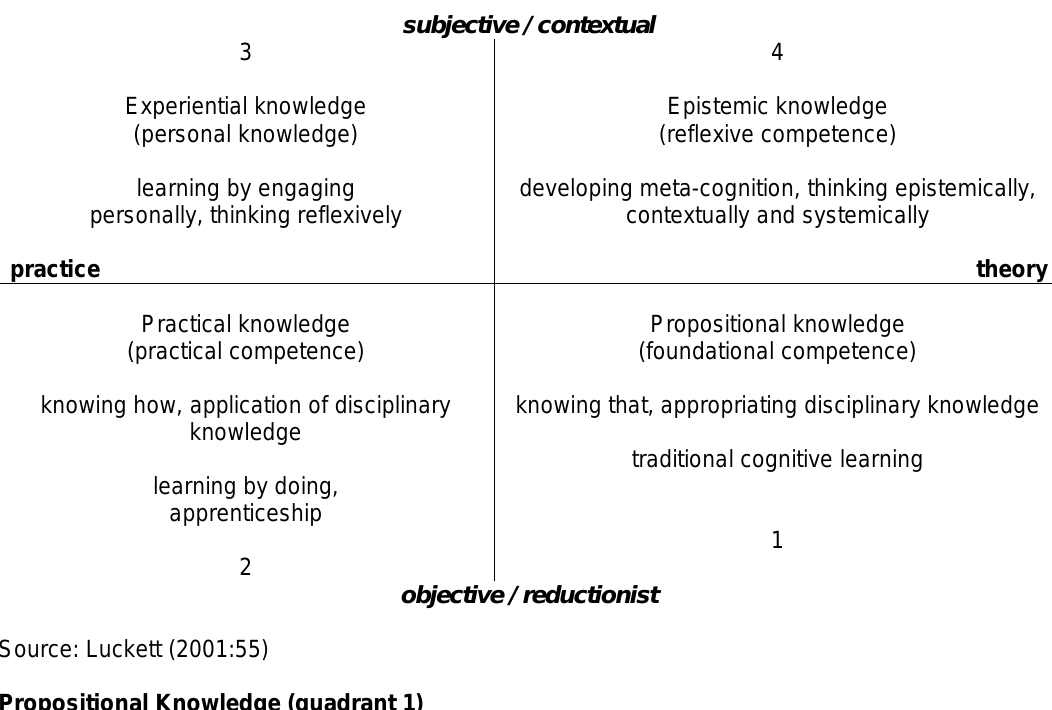
Figure 1: Diagram to illustrate a model of an epistemically diverse